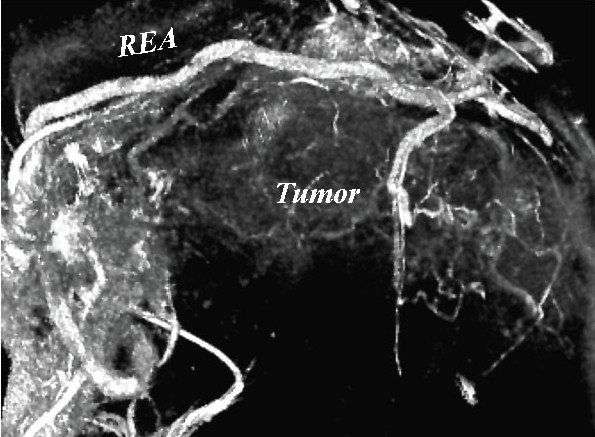
3-D reconstructed angiography of the gastroepiploic artery. A major tumor-supply artery diverges from the right gastroepiploic artery (REA).